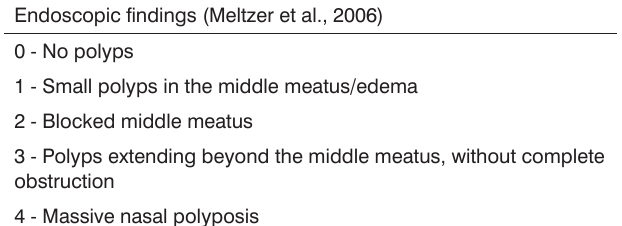
Chart 1. Meltzer scores used to classify nasal endoscopic